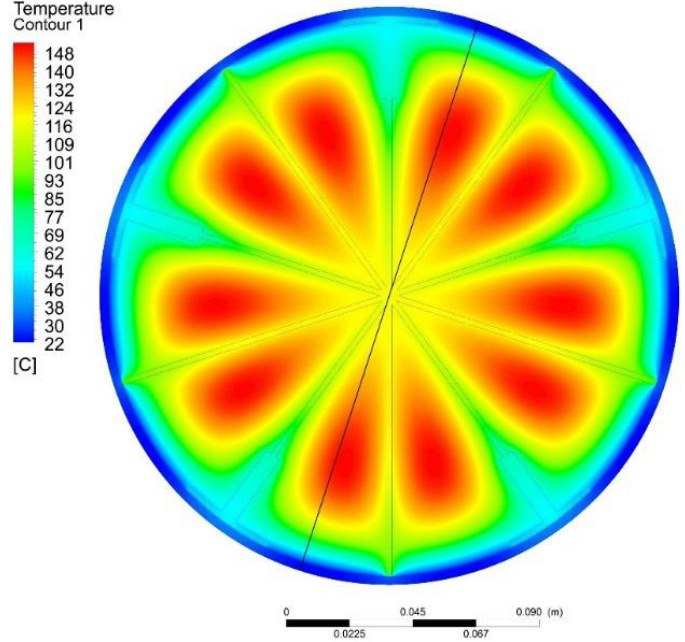
Figure 8. Thermal field in Geometry 2 at 1200 s with a heat transfer intensifier and without cross- flow fins.